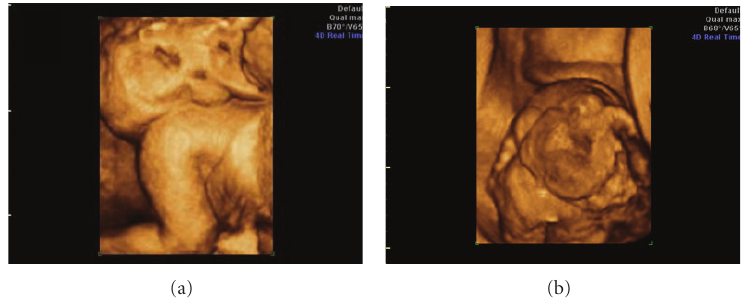
Figure 2: (a) and (b) Three-dimensional ultrasound images of a sacrococcygeal teratoma, in rendering mode, showing the presence of a large mass of lobulated appearance, in which solid components predominated.